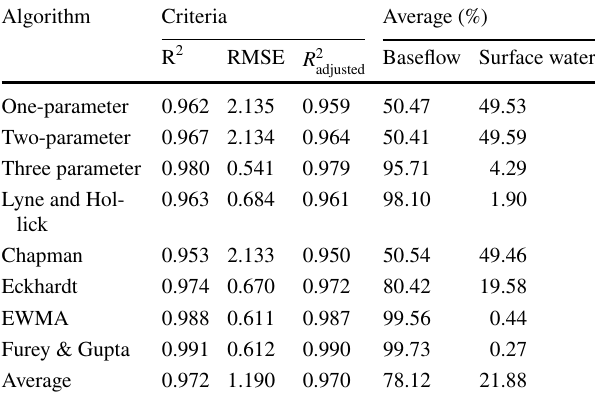
Table 12 Comparison of performance of different algorithms of the RDF